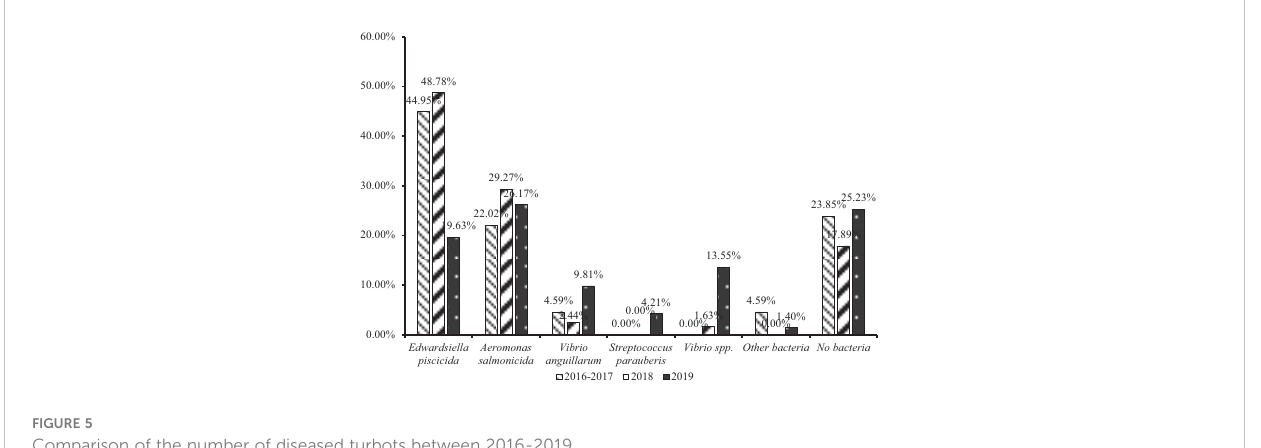
FIGURE 5 Comparison of the number of diseased turbots between 2016-2019.